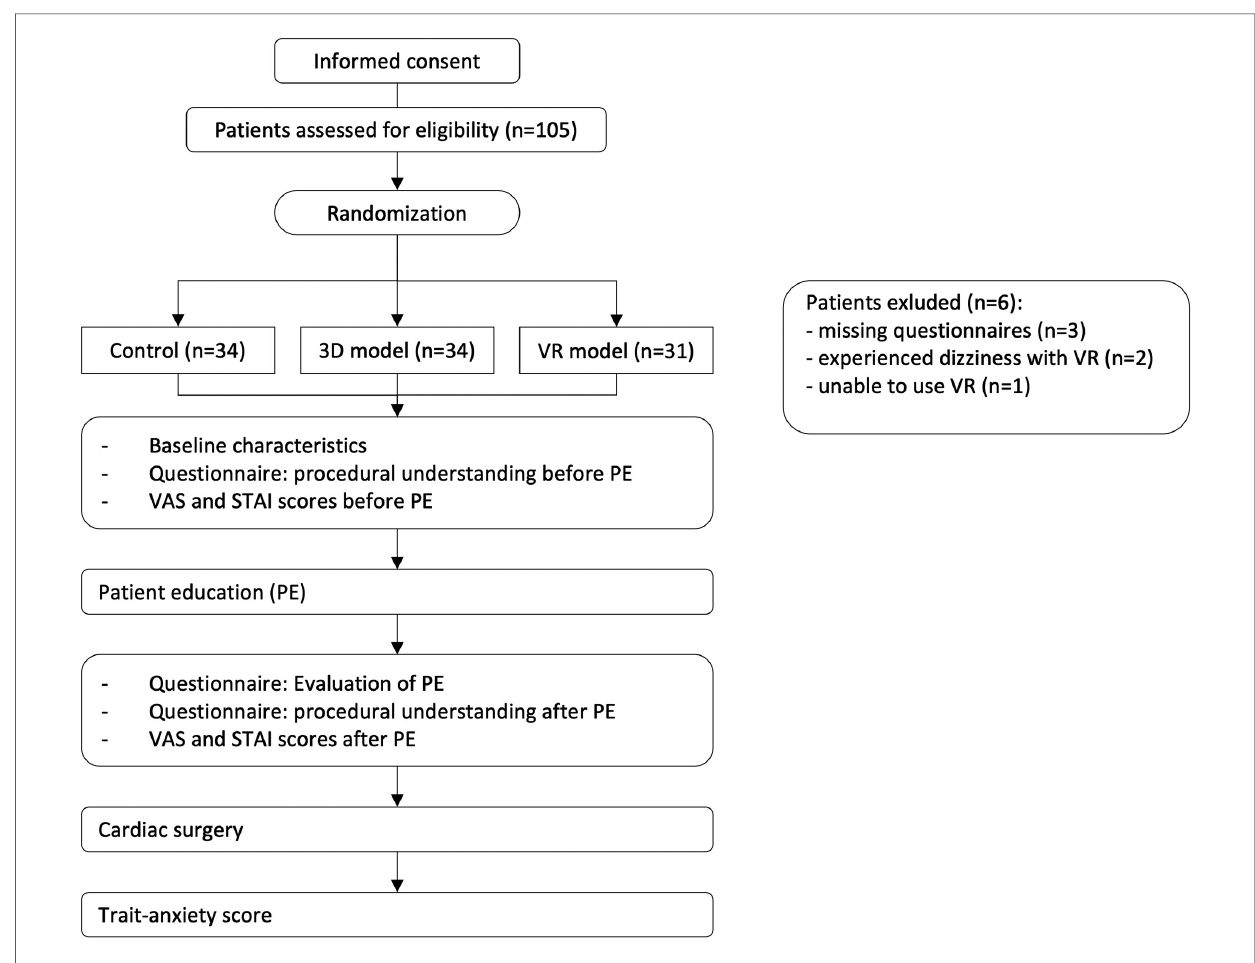
FIGURE 1 Overview of study design and randomization . After informed consent, patients were randomized and completed the described questionnaires at different